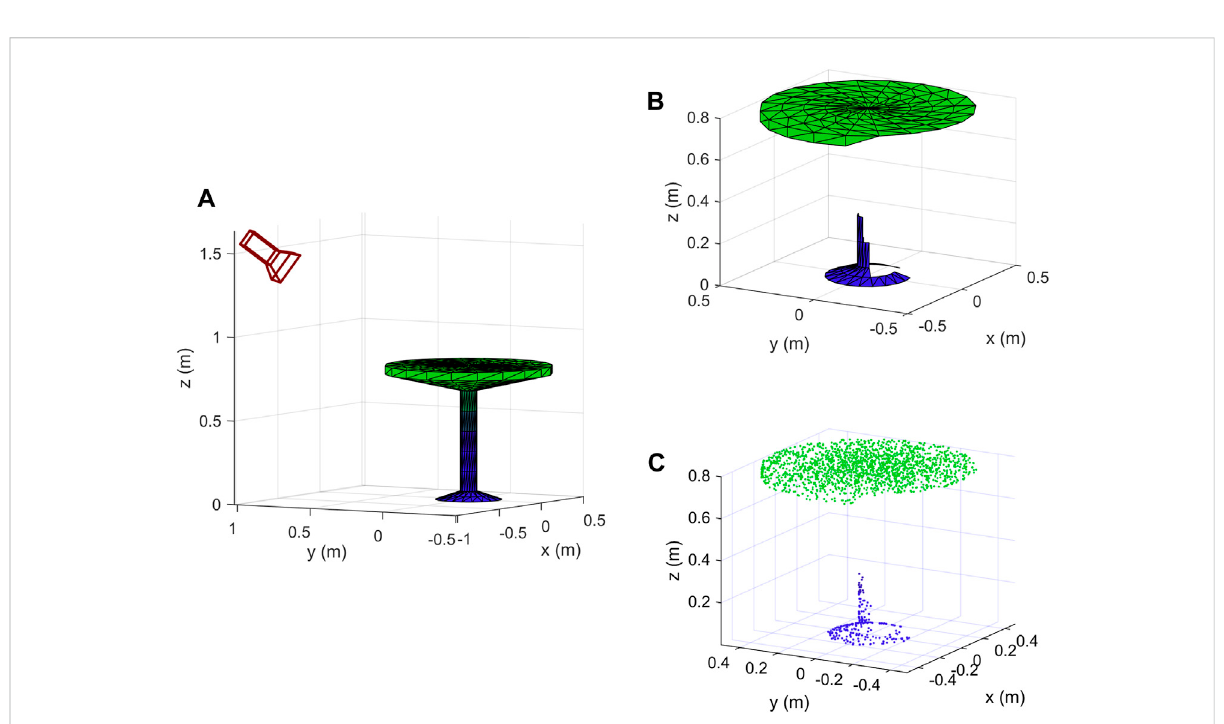
FIGURE 8 Steps of the proposed method: (A) original object with the camera at the speci fi ed location, (B) result of HSR, (C) resulting point cloud after random sampling of visible surfaces.